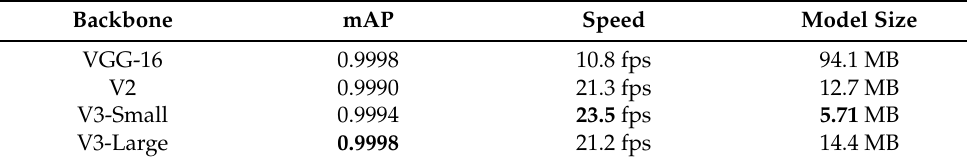
Table 4. Performance of different backbones on gesture recognition dataset. Backbone mAP Speed Model Size VGG-16